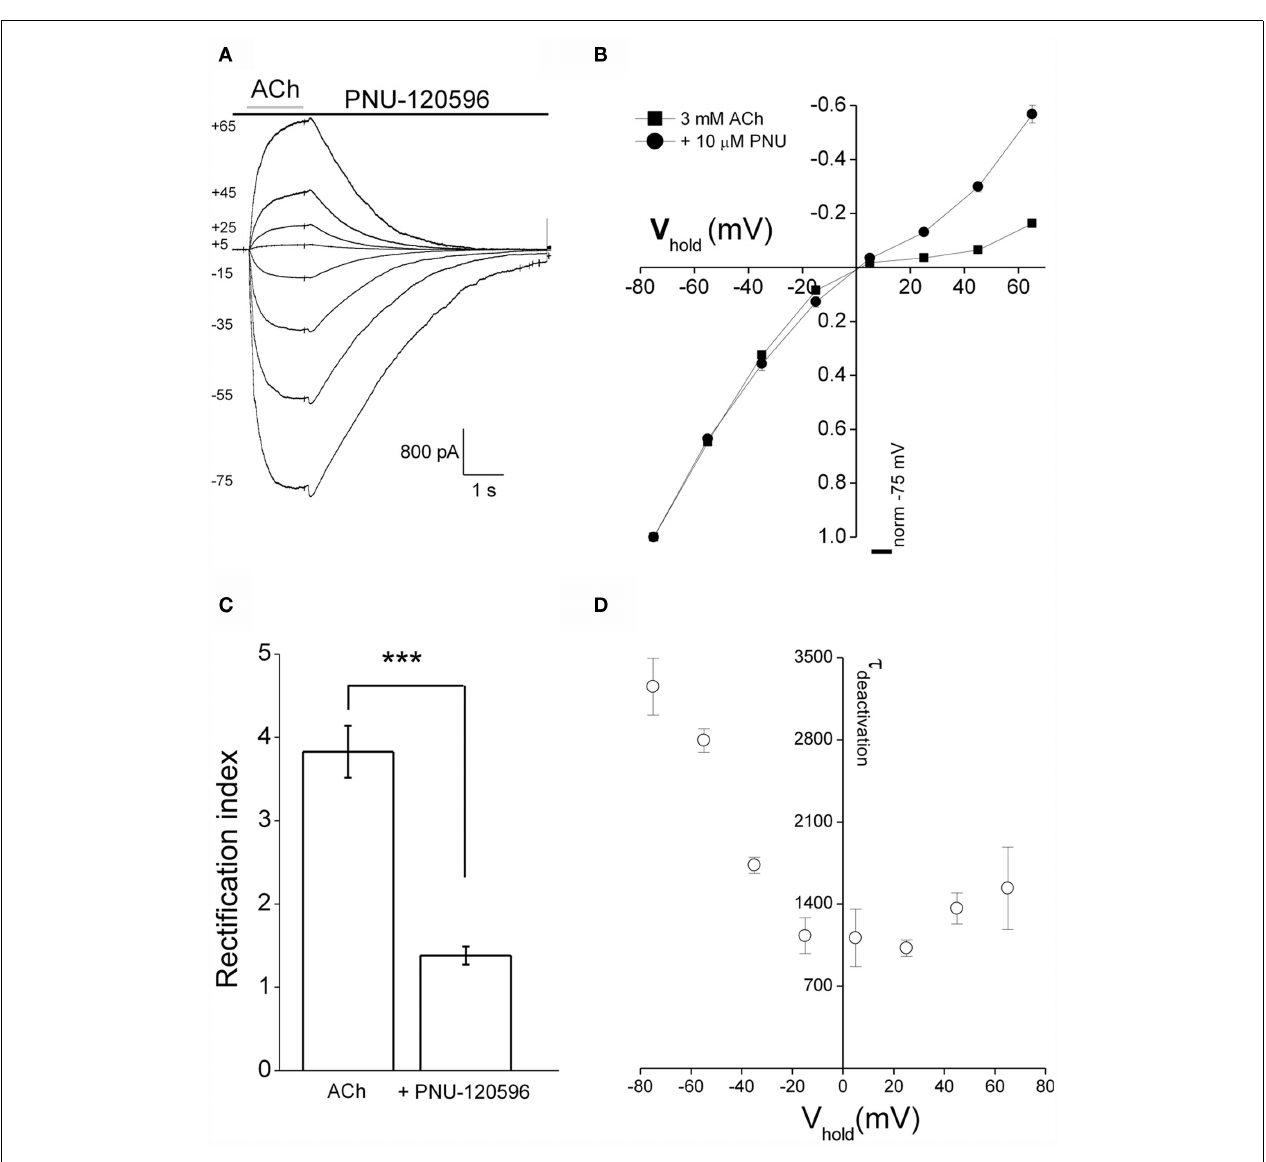
FIGURE 3 | PNU120596 alters voltage-dependence of α 7 nAChR-mediated responses. (A) Currents from a standard I–V relationships in response to ACh (3mM) applied in the continuous presence of 10 μ M PNU120596 at room temperature.The numbers to the left of the traces are the holding potential in millivolt. (B) Pooled I–V relationships for ACh alone (3mM; n = 10, squares) and ACh + PNU120596 ( n = 5, circles). PNU120596-modulated ACh-evoked currents have a more linear I–V relationship while currents recorded in ACh alone show classically strong inward rectification. (C) A comparison of rectification index of currents evoked by ACh alone ( n = 10) and ACh applied in the